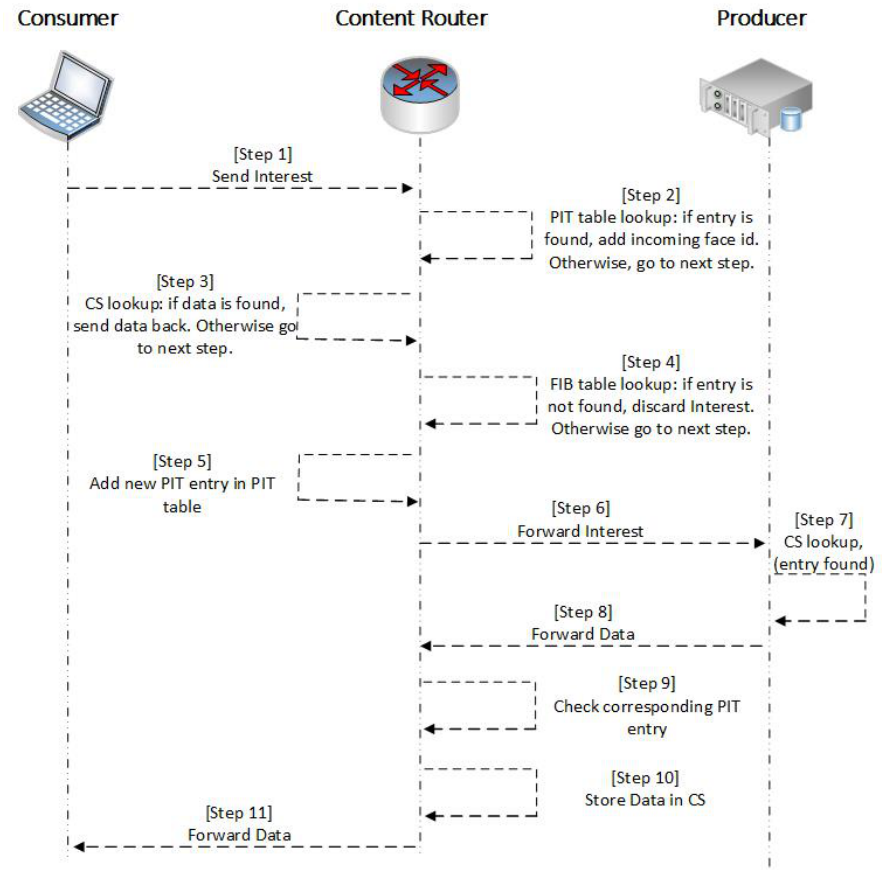
Figure 1. Named data networking (NDN) communication process. CS, content store; PIT, pending interest table; FIB, forwarding information